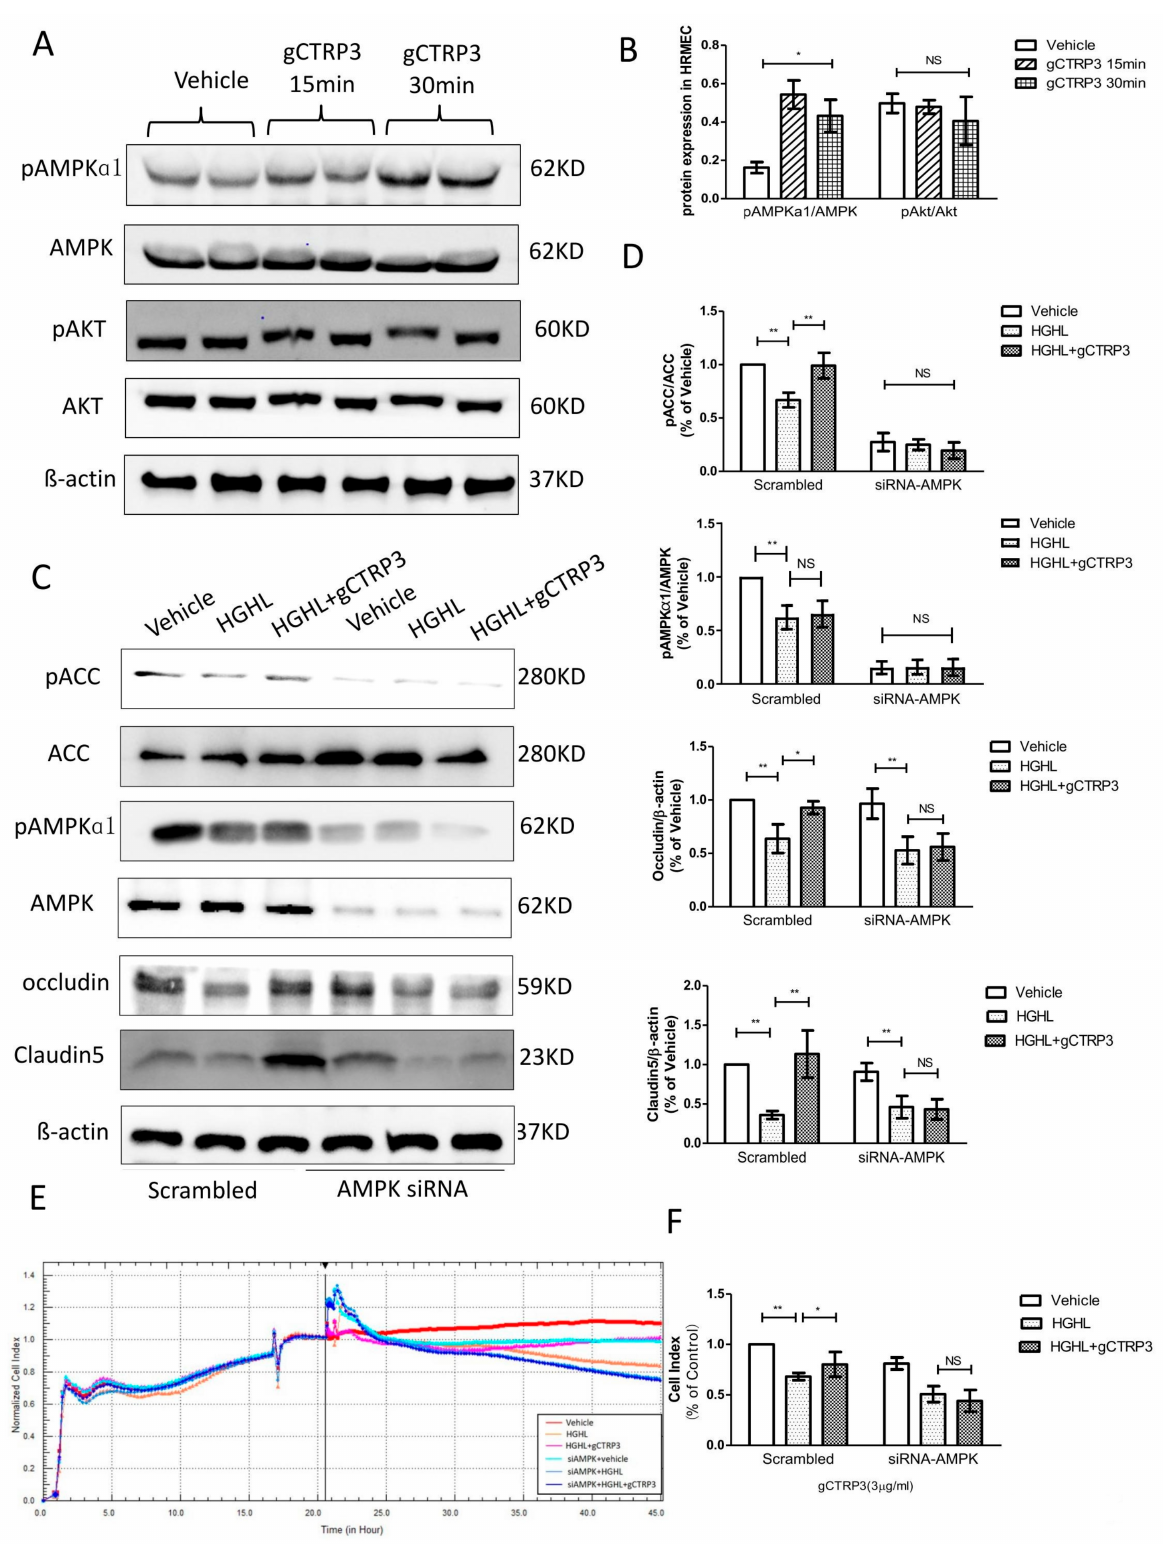
Figure 5. Inhibition of AMPK blocked CTRP3 (cid:48) s role in the upregulation of Occludin and Claudin 5. ( A ), Representative immunoblots show AMPK and Akt activation in HREMCs treated with gCTRP3. ( B ), The bar graph shows the quantification of AMPK and Akt activation. HRMECs were challenged by gCTRP3 (3 µ g/mL) for 15 min followed by HGHL administration ( n = 5–7). ( C ), Western blot analysis confirmed successful knockdown of AMPK by siRNA and expression of pAMPK,